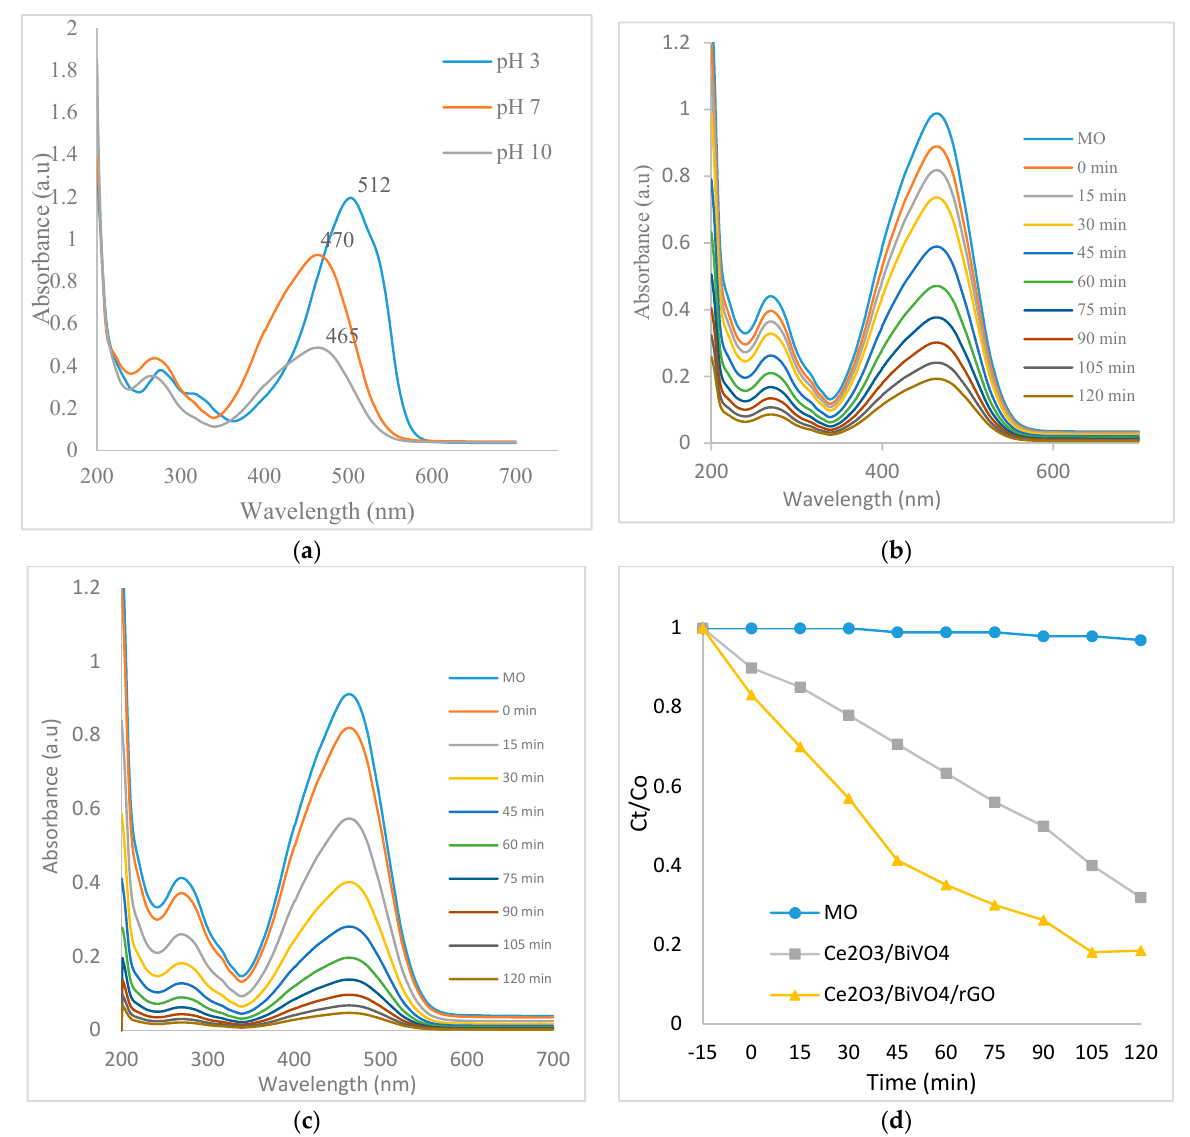
Figure 7. UV–visible absorption spectra of methyl orange ( a ); absorption spectra of the degradation of (MO) using Ce 2 O 3 /BiVO 4 ( b ), Ce 2 O 3 /BiVO 4 /rGO ( c ); and the degradation percentage of MO ( d ), using (5 mg/L catalyst, 1.0 g/L dye concentration, and initial pH 7.0 under visible light irradiation and in the dark).